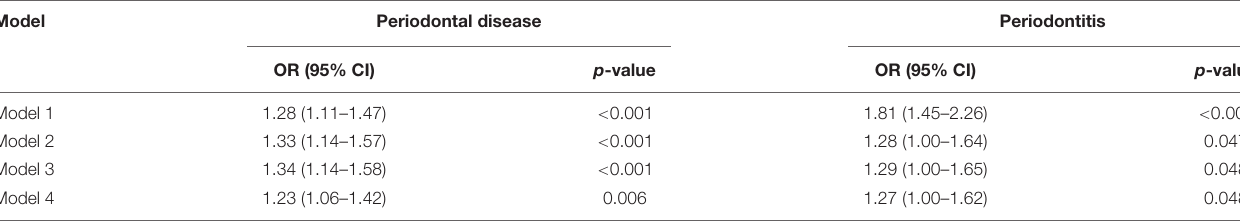
TABLE 2 | Multivariable analysis results of relationship between periodontal disease and